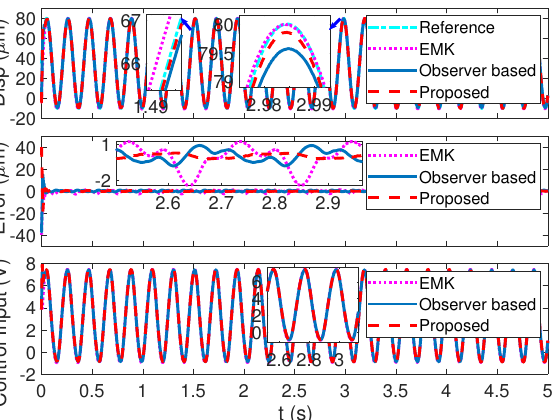
Figure 13. Experimental results of the three control methods (10 rad/s).